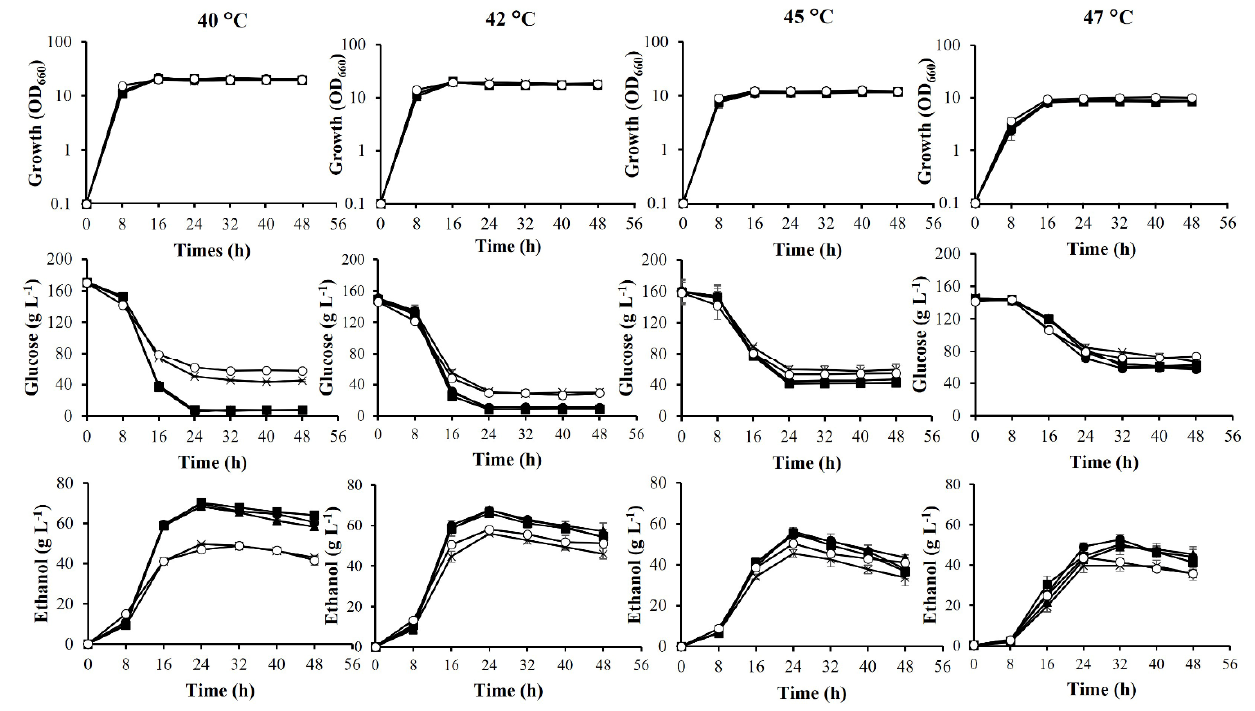
Figure 2. Fermentation of adapted strains in YP medium containing 16% glucose at high temperatures. Wild-type ( (cid:53) ), ACT001 ( • ), ACT002 ( (cid:78) ), ACT003 ( (cid:4) ), and TML001 ( ) strains were cultivated in YP medium containing 16% glucose at 40–47 ◦ C under a shaking condition at 100 rpm, and samples were taken every 8 h until 48 h. Growth was determined by measuring OD 660 . Glucose, ethanol, and acetate were determined by HPLC. Error bars represent ± SD of values from experiments performed in triplicate.